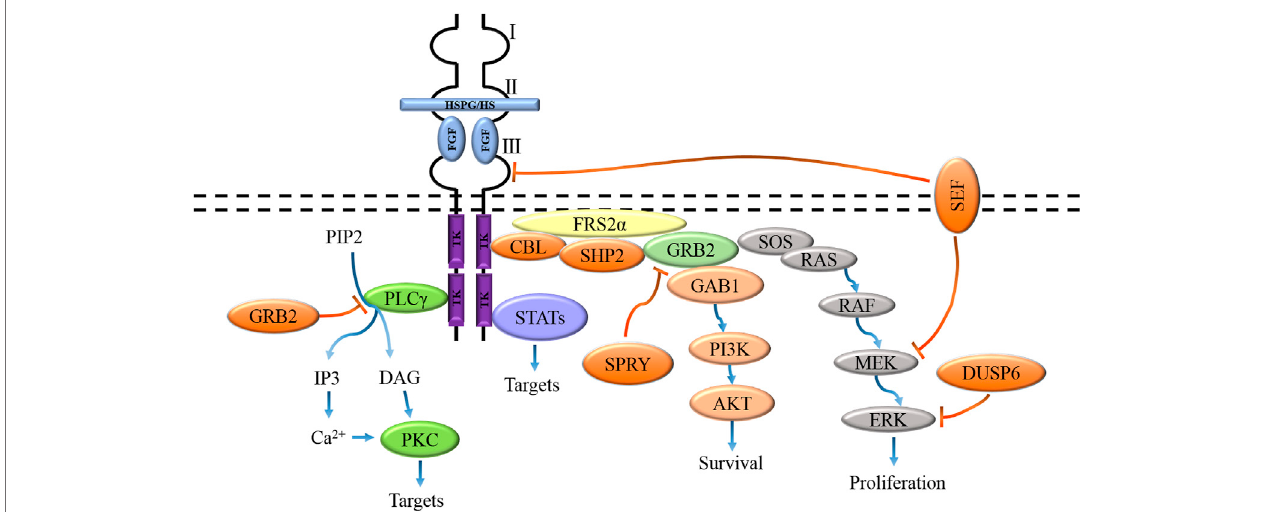
FIGURE 3 | FGFs activate signaling pathways coupled to the cell by interacting with speci fi c FGFRs and HS/HSPGs to activate receptors, including the RAS- MAPK, PI3K-AKT, PLC- γ , and STAT pathways. These pathways are negatively regulated by GRB2, DUSPs, SPRY, SEF, and CBL